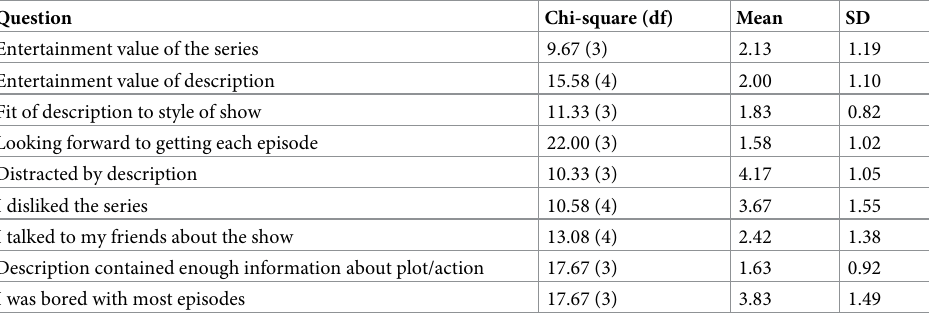
Table 2. Chi-square, mean and standard deviation (SD) results for all questions with p <